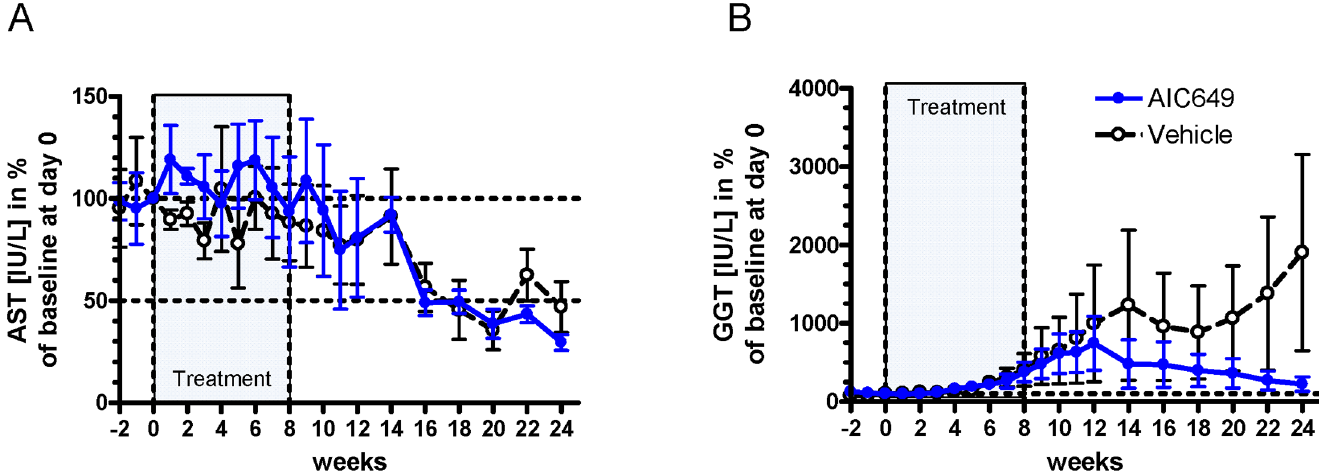
Fig 6. AIC649 treatment is associated with changes in serum activities of liver enzymes in chronic WHV carrier woodchucks. AIC649 (3.9 x 10 6 Units (ELISA-based titer)) or vehicle were administered i.m. twice weekly for 8 weeks (marked “ Treatment ” ). At the indicated time points woodchucks were bled and serum was used to analyze levels of liver enzymes. Values were normalized to individual baseline at day 0 and are given in %. n = 5 / group. Dotted lines: 100% or 50% level. (A). Group means of AST concentration +/- SEM. (B) Group means of GGT concentration +/- SEM.